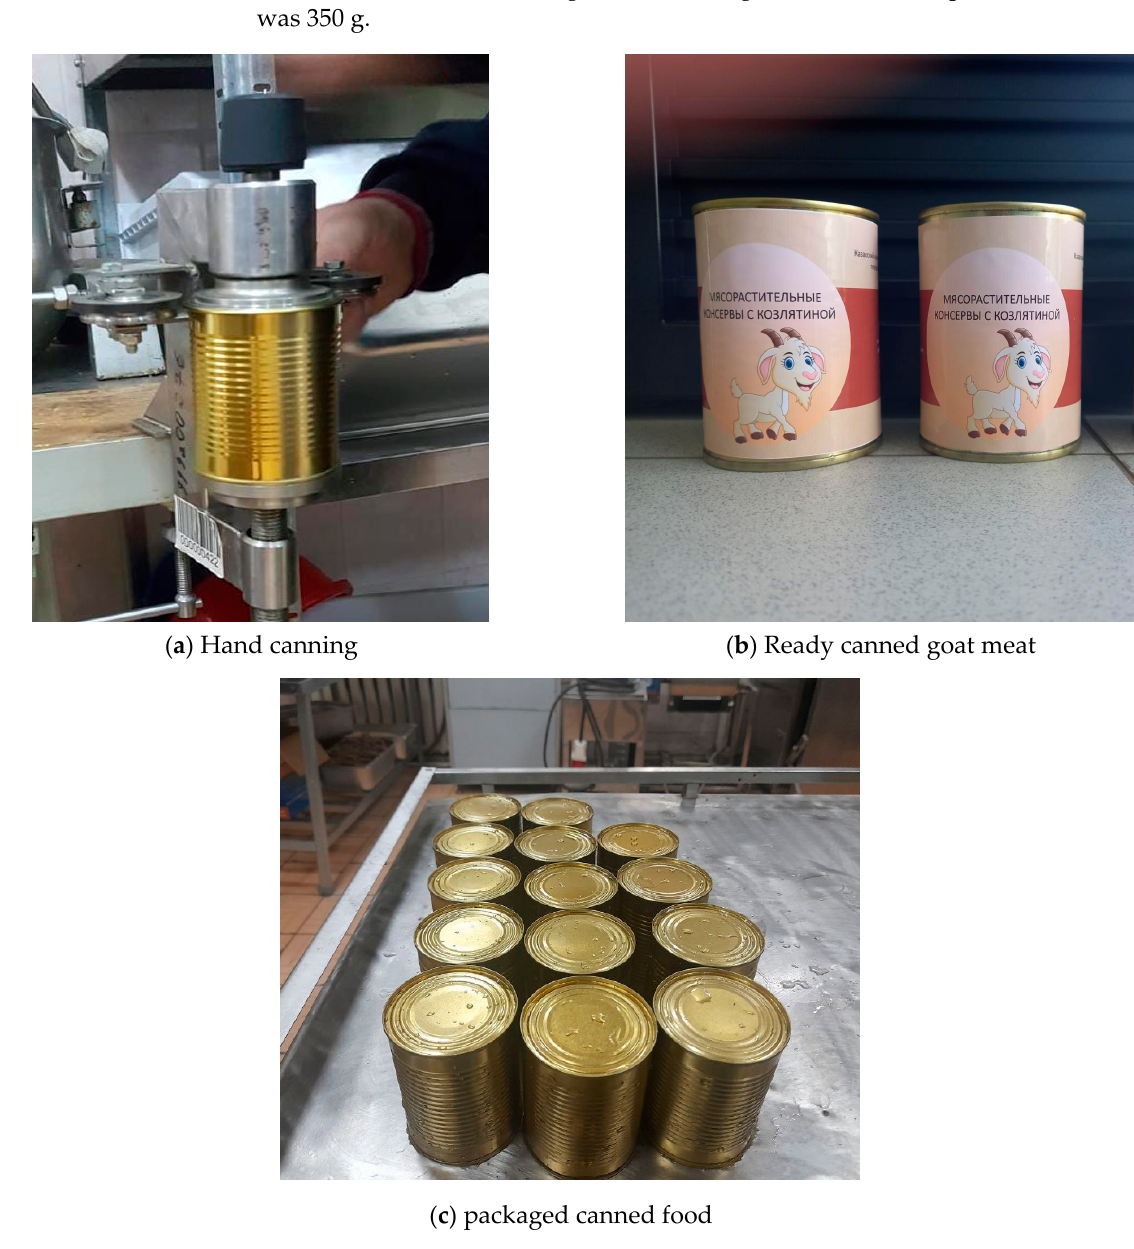
Figure 1. Canned goat meat